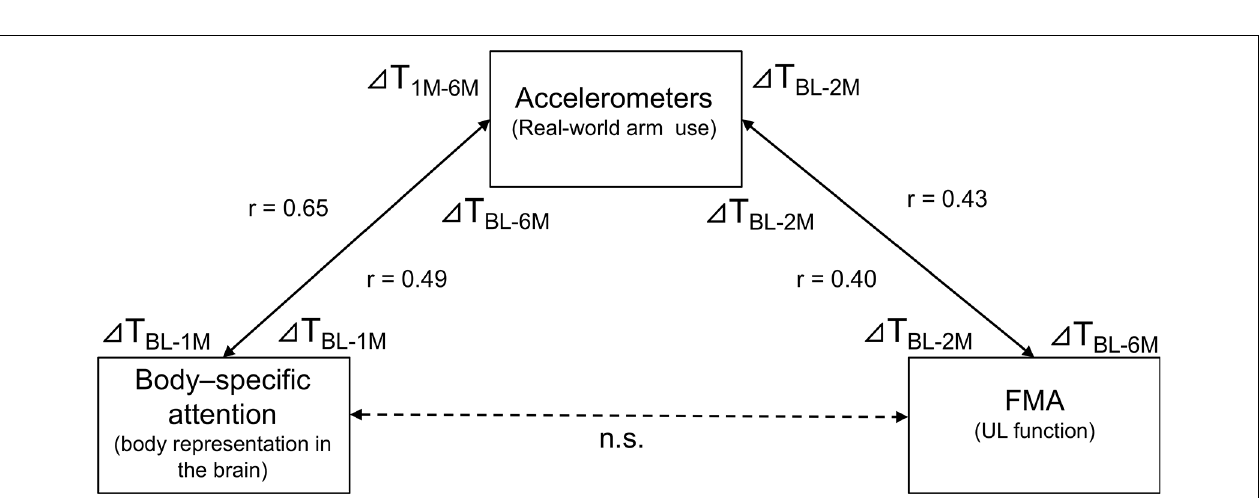
FIGURE 5 | Relationship between changes in body-specific attention, real-world arm use, and UL function as revealed by correlation analysis using longitudinal data. There was a significant positive correlation between the amount of change in body-specific attention from baseline to 1 month and the change in real-world arm usage from baseline to 6 months ( r = 0.491, p = 0.013). Moreover, there was a significant positive correlation between the amount of change in body-specific attention from baseline to 1 month and the change in real-world arm use from 1 month to 6 months ( r = 0.649, p < 0.01). The amount of change in real-world